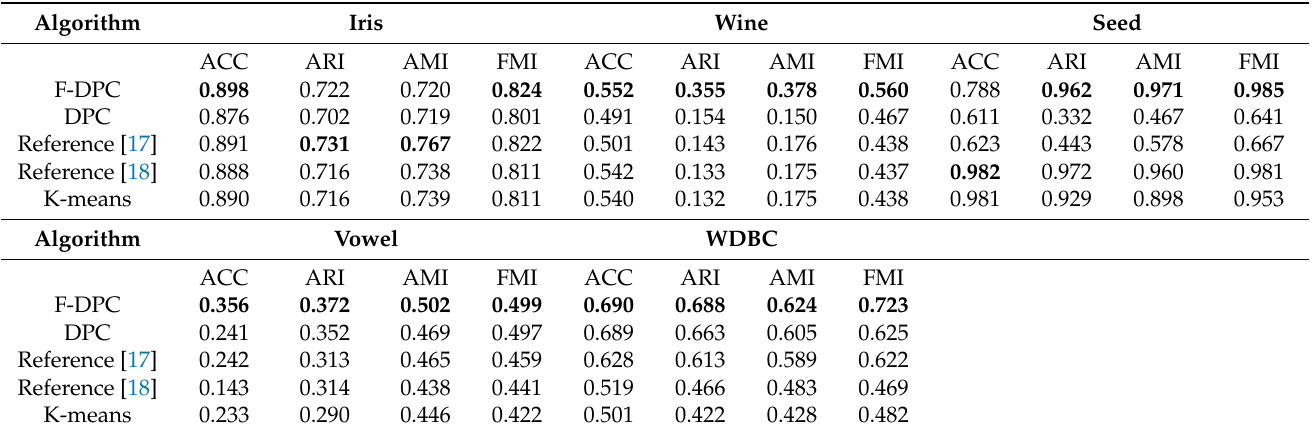
Table 4. UCI real datasets clustering